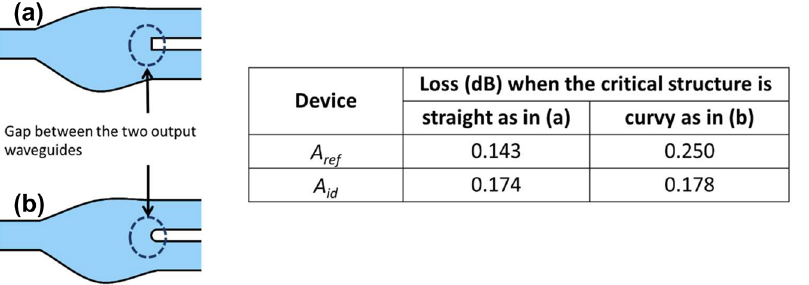
Figure 10: The structure in the proximity of the gap between the two output waveguides (a) straight, (b) curvy. The FDTD losses for the devices A when the structure in vicinity of the gap is assumed as (a) and A ref